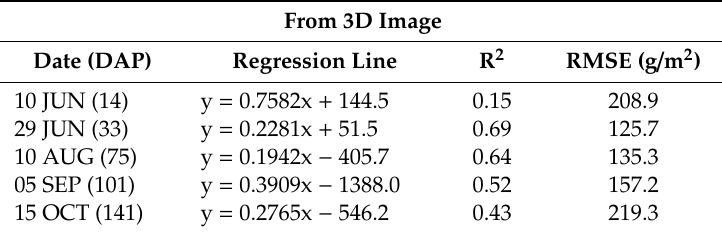
Table 2. The comparison of sweet potato dry weight and estimated LAI based on 3D models. From 3D